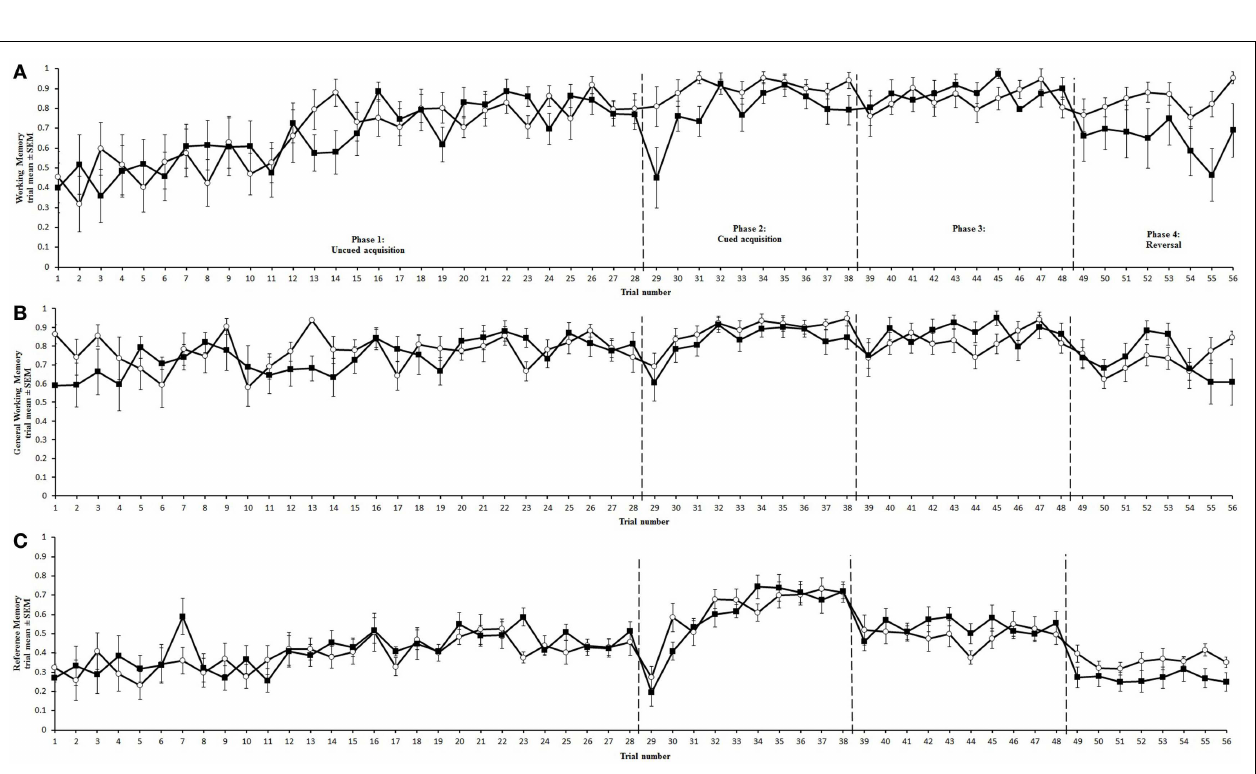
FIGURE 4 | Memory performance of aviary ( ◦ ) and cage-reared ( (cid:4) ) chickens in the holeboard task .Working memory (A) , General working memory (B) , and reference memory (C) are presented as mean and standard error of the mean (SEM). Dashed lines mark the transitions between uncued, cued, over-training, and reversal